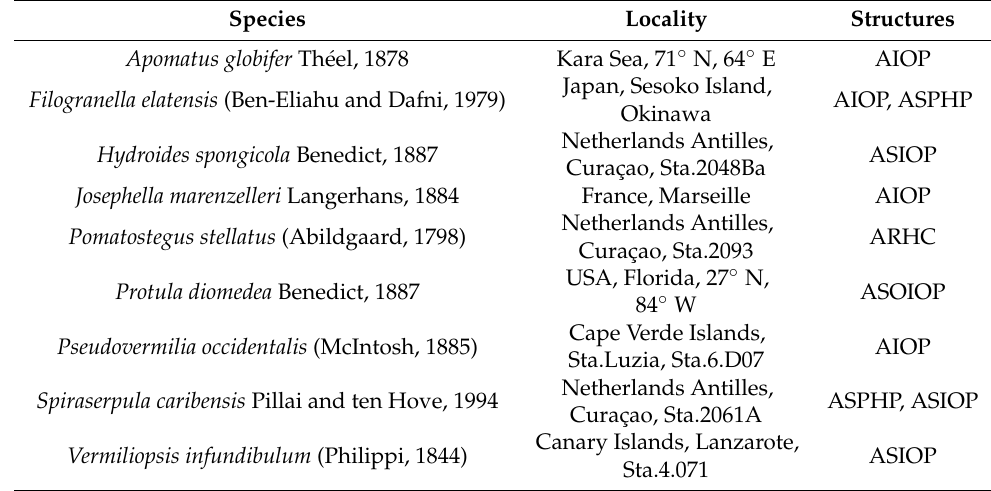
Table 1. The locality information and data on the tube microstructures. Species Locality